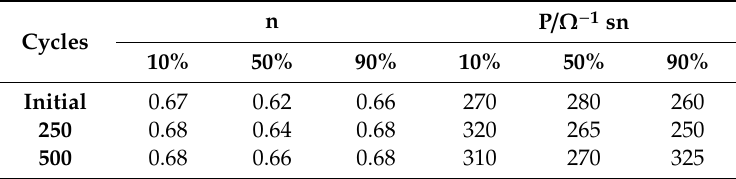
Table 2. Fitting Parameters for The Low Frequency Tail.